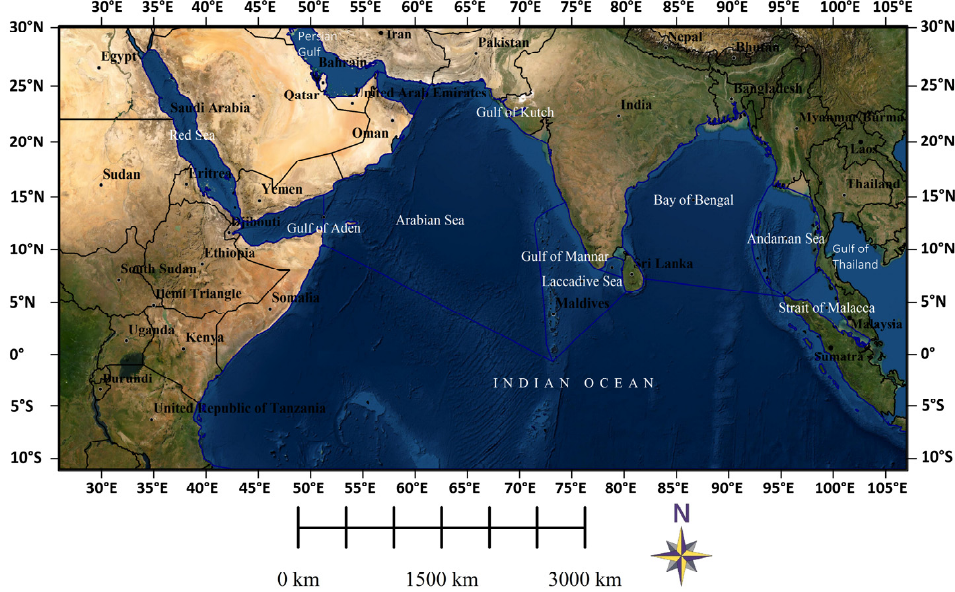
Figure 1. Study domain considered for evaluation of CMIP5 GCM’s skill in representing near-surface wind speed.